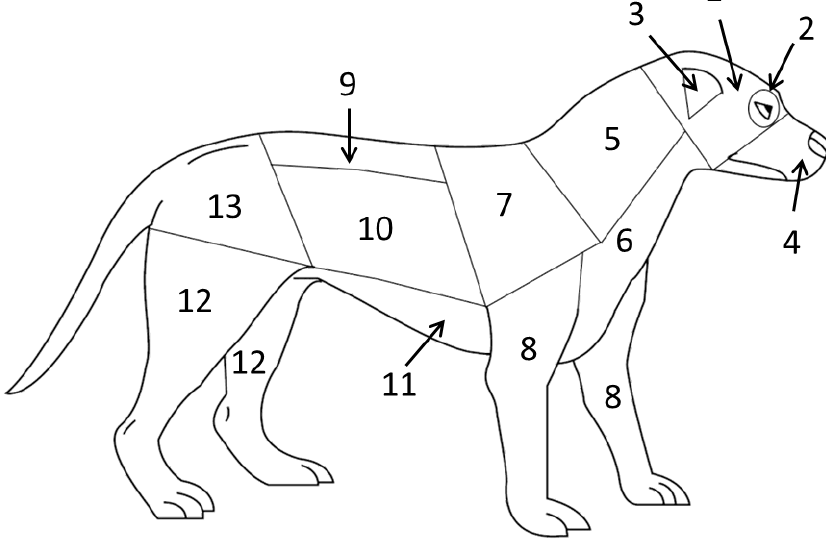
Figure 1. Body surface zones used for categorizing location of wounds and scars [1]. The 13 body surface zones are: ( 1 ) the dorsal and lateral head; ( 2 ) the eye and periorbital region; ( 3 ) the pinnae; ( 4 ) the muzzle and oral mucosa; ( 5 ) the dorsal and lateral neck; ( 6 ) the ventral neck and chest; ( 7 ) the scapular region; ( 8 ) the front legs; ( 9 ) the thoracic and lumbar spine; ( 10 ) the lateral thorax and abdomen; ( 11 ) the ventral thorax and abdomen; ( 12 ) the hind legs; and ( 13 ) the pelvis and tail. Figure used with permission.